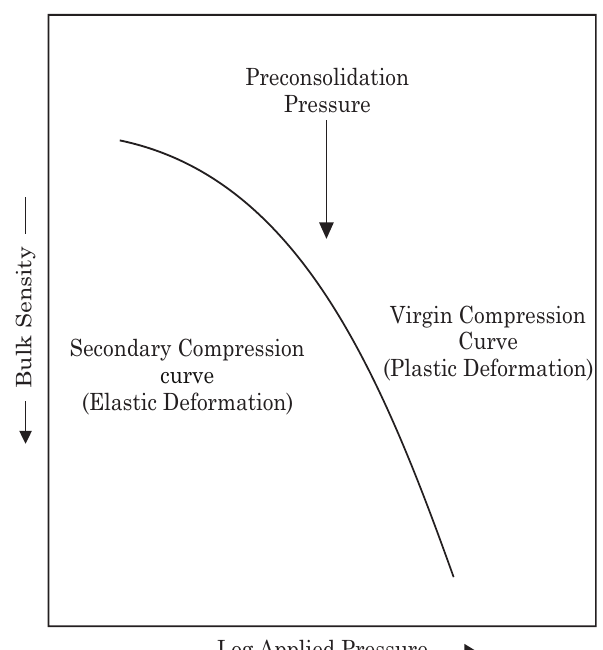
Figure 1. Soil compression